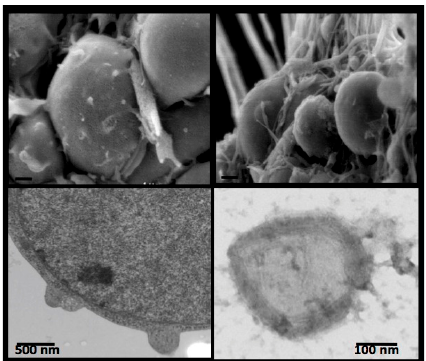
Figure 4. Cell membrane budding and blebbing (mouse cortical neurons) visualised by scanning (upper micrographs) and transmission (bottom micrographs) electron microscopy. An isolated microvesicle is depicted in the lower right micrograph [42].